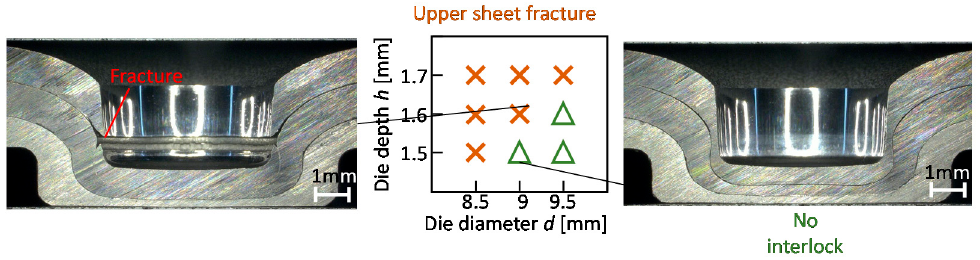
Figure 24. Joining range for sheet combination of two 980 MPa steel and aluminium alloy sheets.